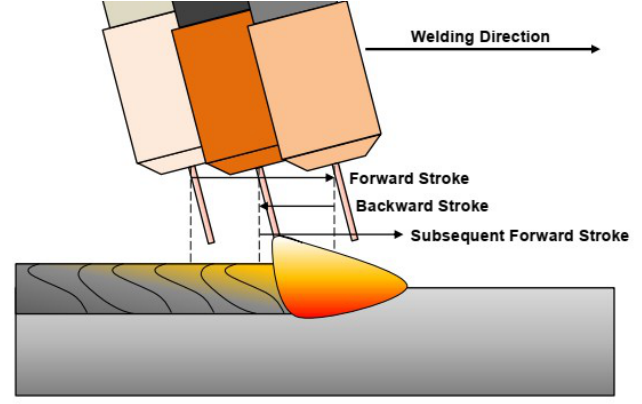
Figure 1. Periodic oscillation scheme of the torch with the switchback technique.